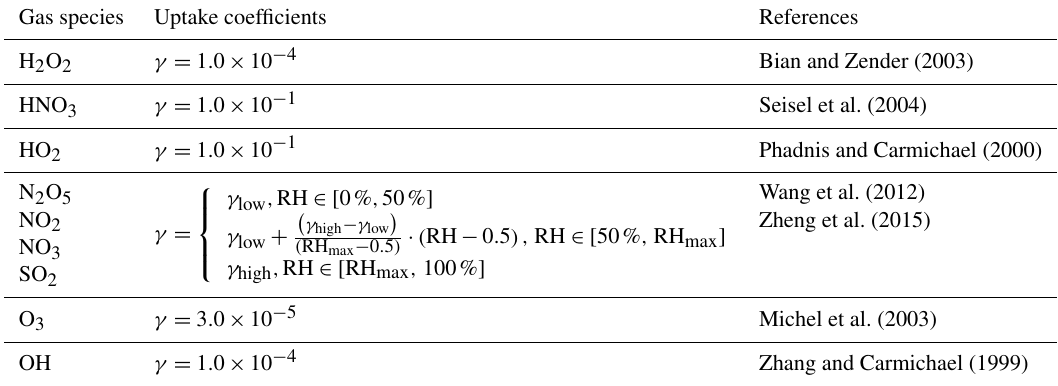
Table 1. Uptake coefficients for Reactions (R1)–(R9). Gas species